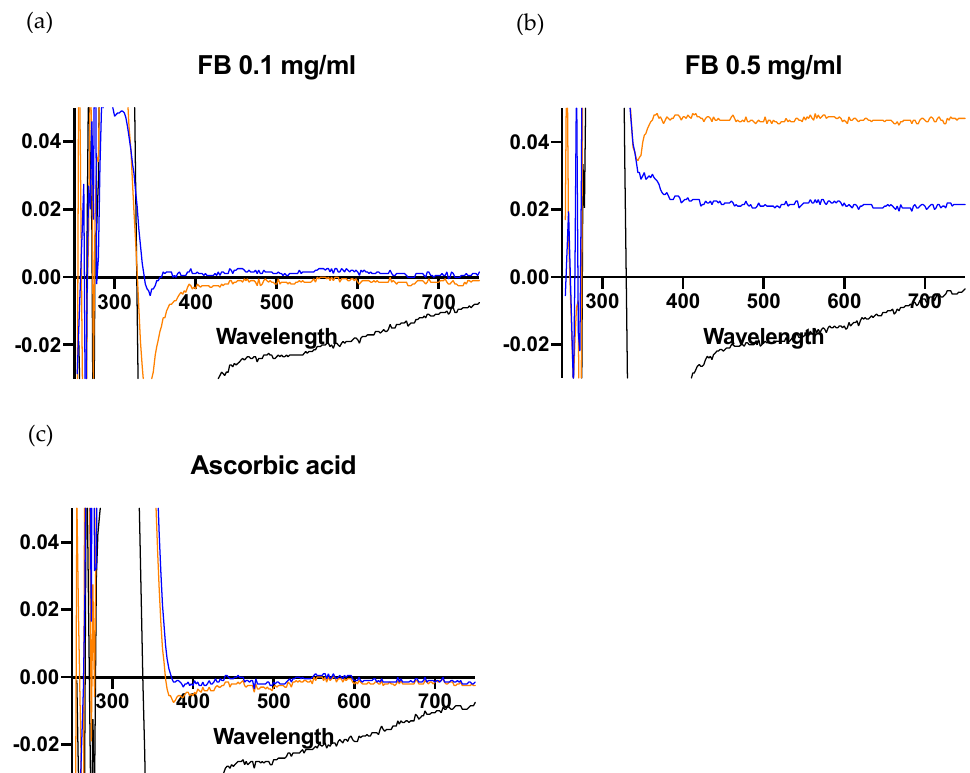
Figure 8. Effects of FB ( a,b ) and ascorbic acid ( c ) on the UV-VIS spectrum. Data show the effects of the different antioxidant agents 5 h and 24 h after blue light irradiation. Differential spectra were taken against the controls without the treatments.